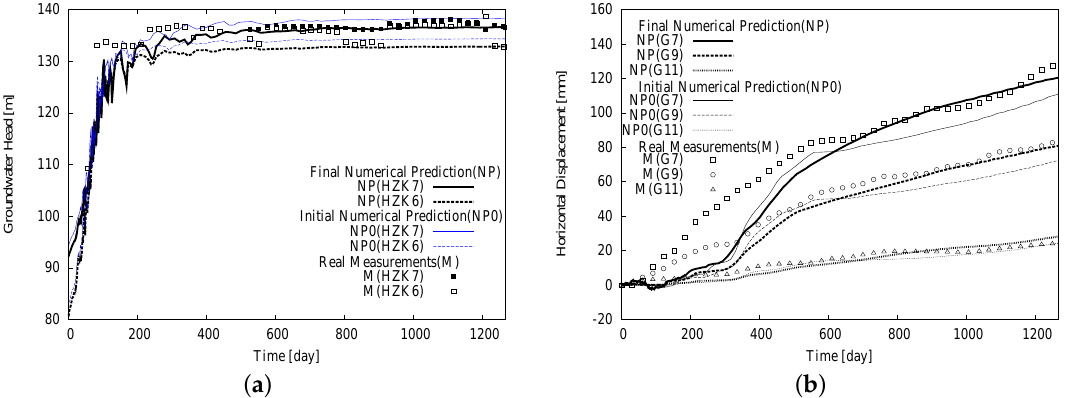
Figure 11. Comparison between the numerical prediction and measurement data after the back analysis for: ( a ) groundwater level at HZK6 and HZK7; ( b ) horizontal displacement at G7, G9 and G11. (NP—final numerical prediction after back analysis; NP0—initial numerical prediction; M—real